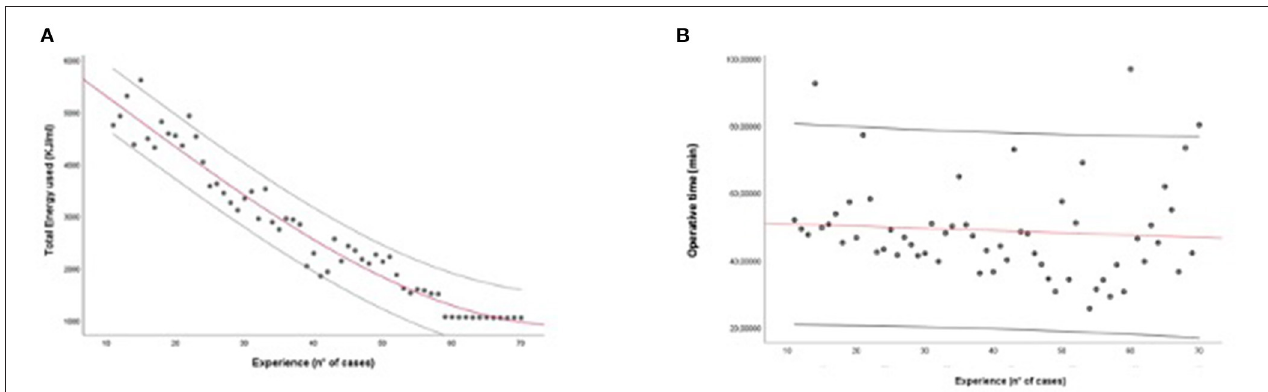
FIGURE 3 | (A,B) Linear regression: Total energy adopted/number of procedures (A) and total operative time/number of procedures (B) during the training process.